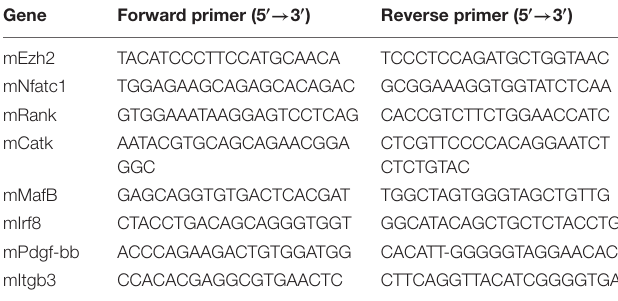
TABLE 1 | qPCR primers for mouse mRNA analysis. Gene Forward primer (5 (cid:48) → 3 (cid:48)